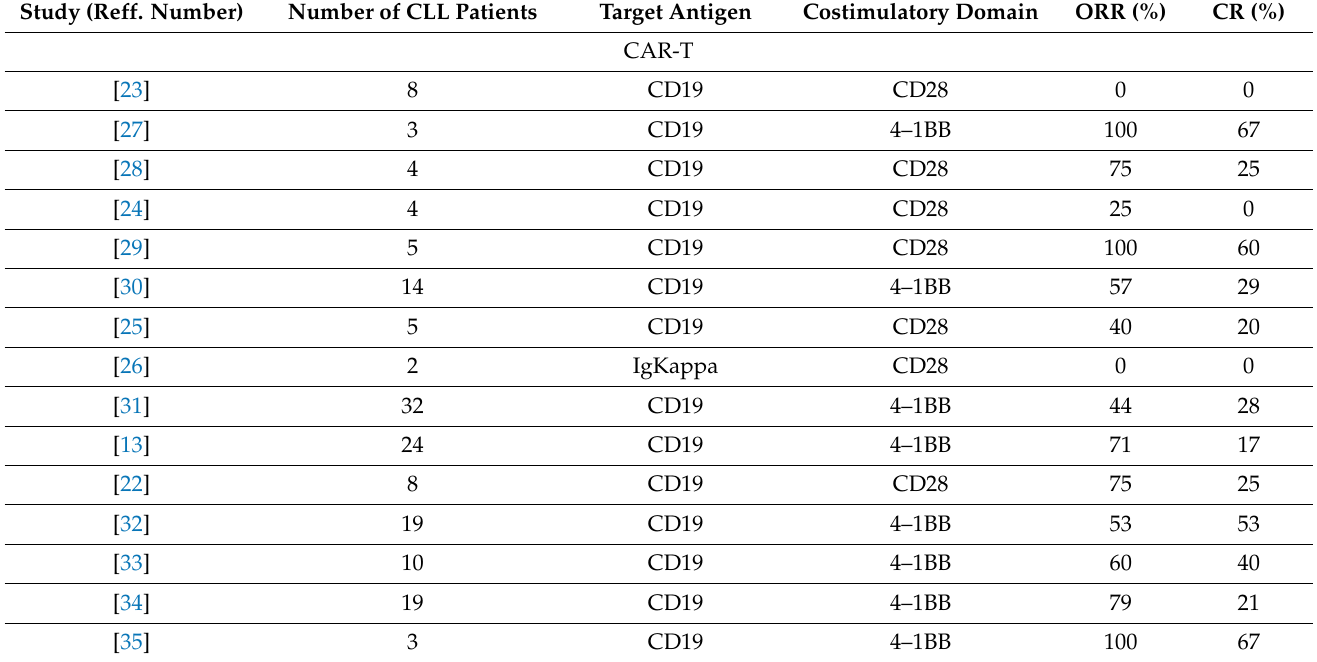
Table 1. CAR T cells trials in CLL. Abbreviation: ORR—overall response rate, CR—complete response, CLL—chronic lymphocytic